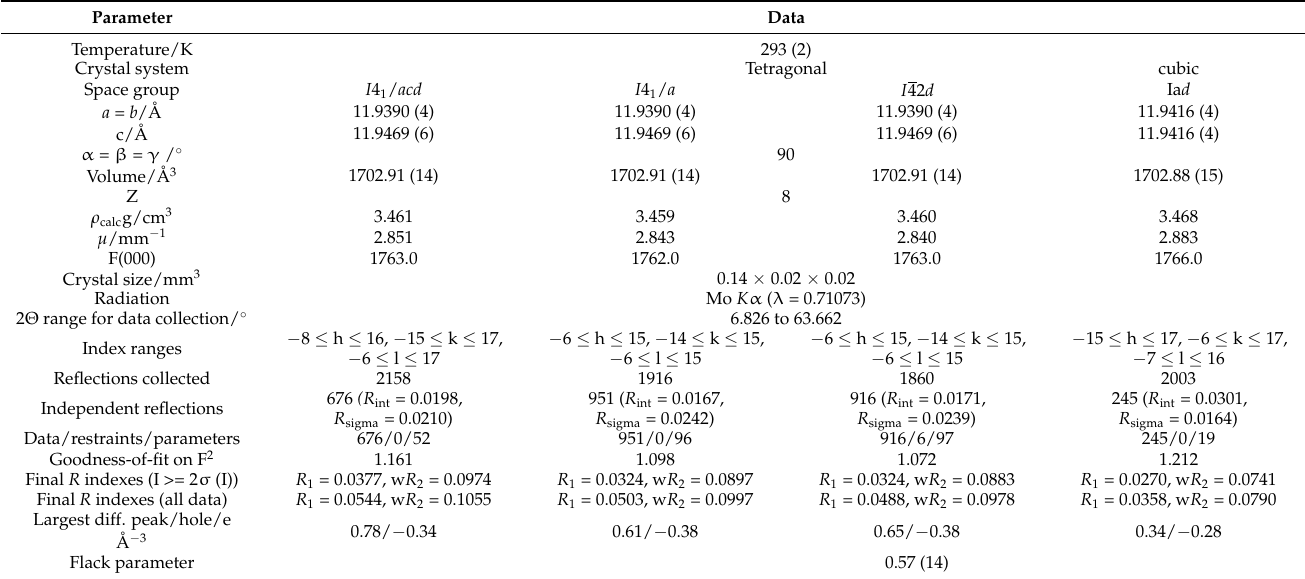
Table 2. Crystal data, data collection information, and refinement details for (H 4 O 4 ) 4 − -substituted grossular from Wiluy River, Yakutia, Russia.